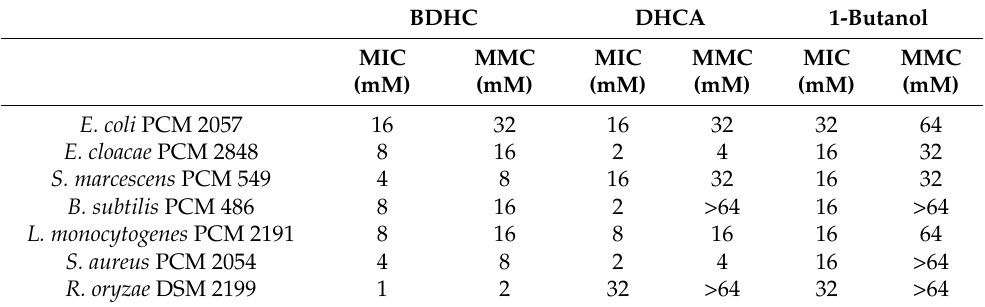
Table 2. Comparison of the antimicrobial activity of dihydrocaffeic acid butyl ester and its precursors.